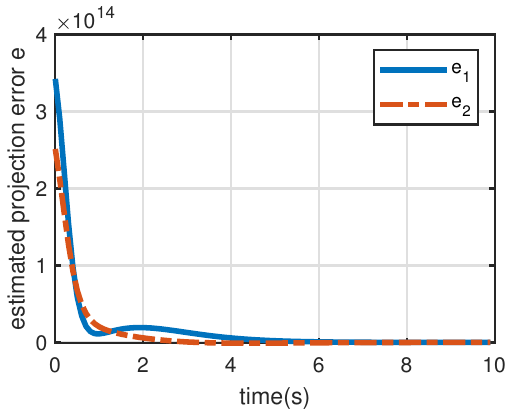
Figure 9. The time histories of estimated projection error.